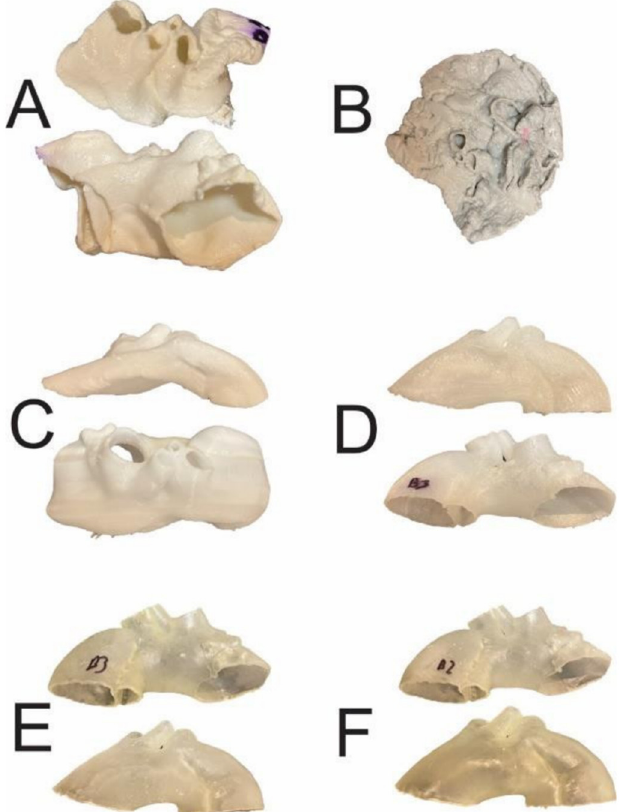
Figure 7. The 3D aortic templates after sterilization in 121 ◦ C autoclave. Templates made of PLA ( A ), PETG ( B ), and PP ( C ) were affected by significant deformations, whereas those made of nylon (D), rigid ( E ) and flexible resins ( F ) were intact. PLA-polylactic acid; PETG-polyethylene terephthalate glycol; PP-polypropylene. Reprinted with permission under the open access from Rynio et al. [66].